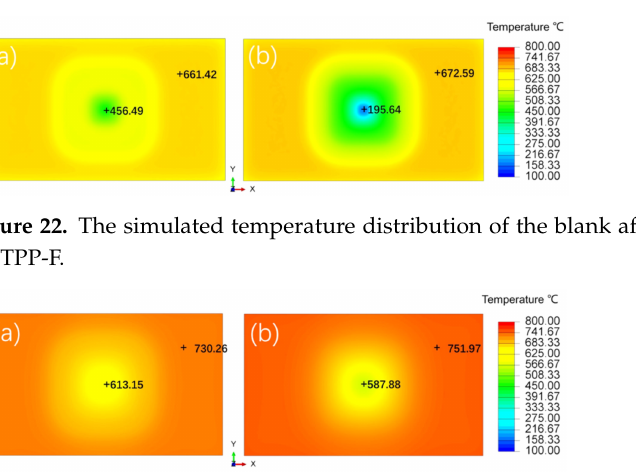
Figure 21. The temperature distribution of the blank after cooling in the acquisition region of the thermal imager. ( a ) TPP-S; ( b ) TPP-F.